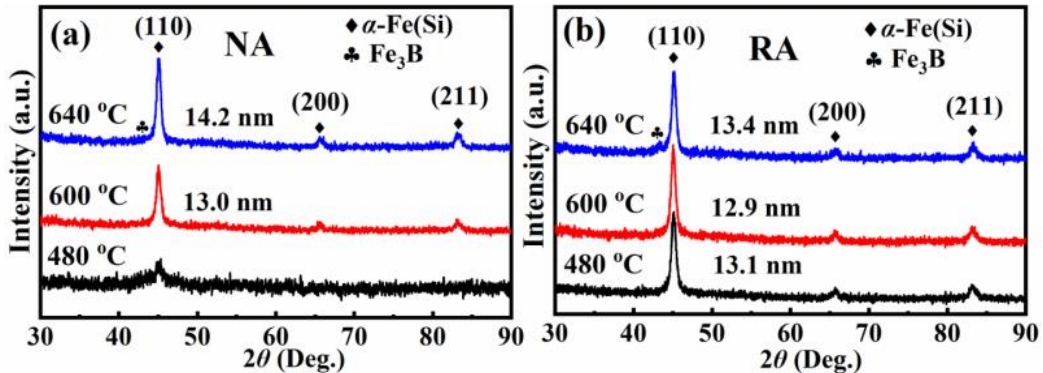
Figure 4. XRD patterns of Mn2 by ( a ) NA and ( b ) RA at different T a .